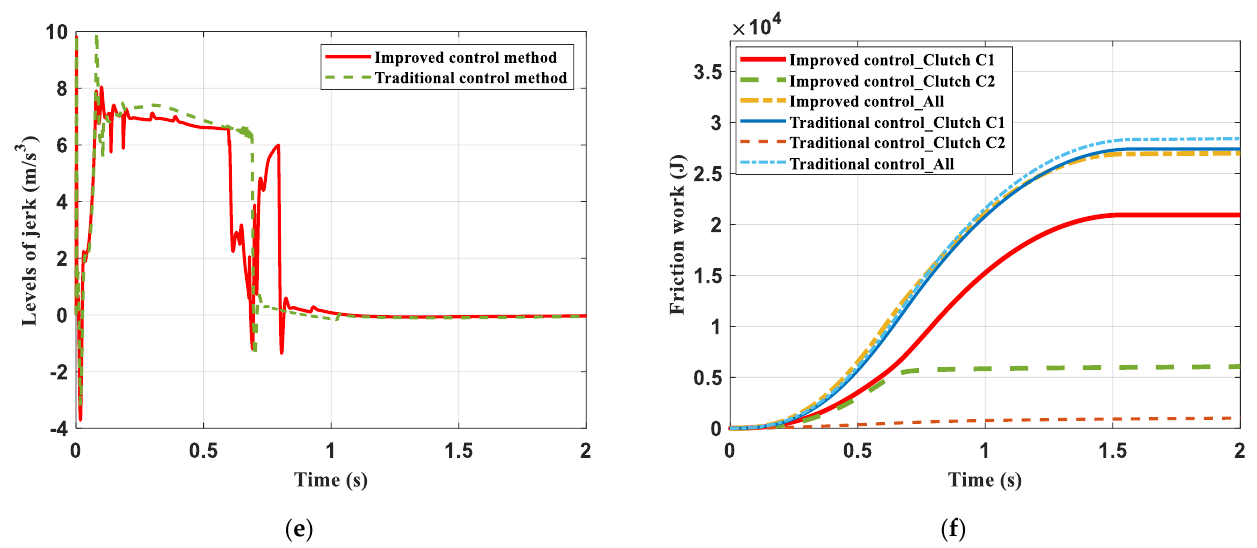
Figure 10. The simulation results of quickly starting of the traditional control strategy and the proposed control strategy. ( a ) The speed of main components with the improved control strategy; ( b ) The speed of main components with the traditional control strategy; ( c ) The target and actual torque of the clutch with the improved control strategy; ( d ) The target and actual torque of the clutch with the traditional control strategy; ( e ) Level of jerk with different control strategy; ( f ) Friction work with different control strategies.